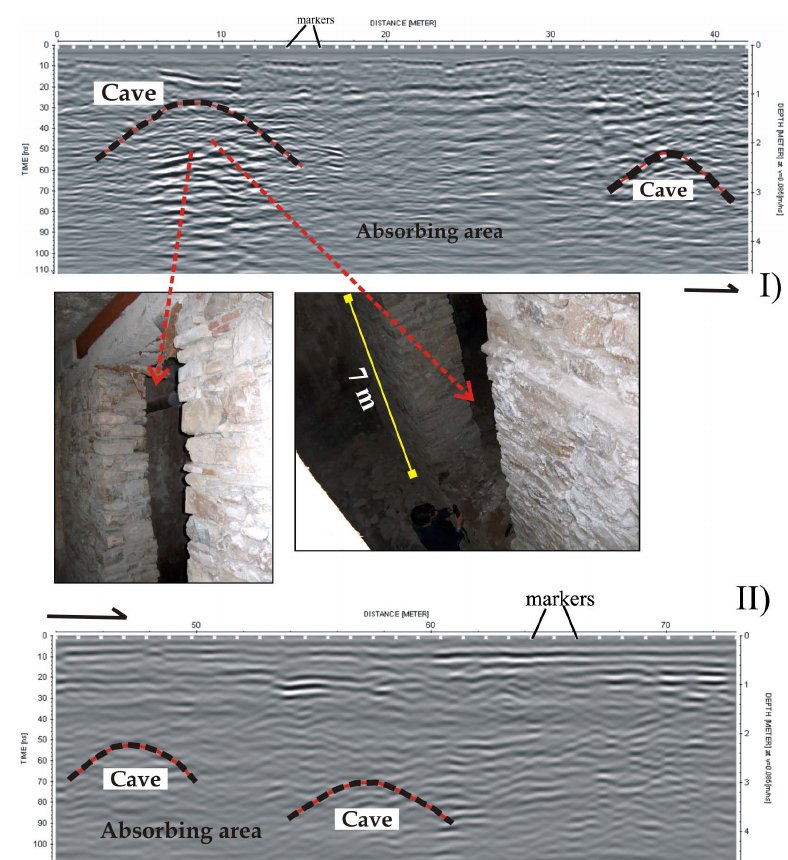
Fig. 9. Radargrams carried out along Duca degli Abruzzi street shows a very large cave with a vault 7m high and perimetric stone walls (I). In this case the high risk level is due to the extremely reduced diaphragm between the empty cave and the overhanging Duca degli Abruzzi